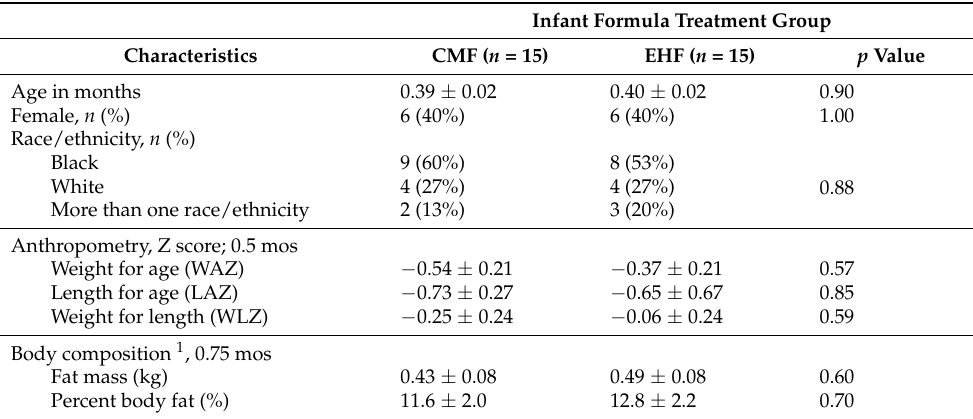
Table 1. Baseline characteristics of study cohort at study entry (0.5